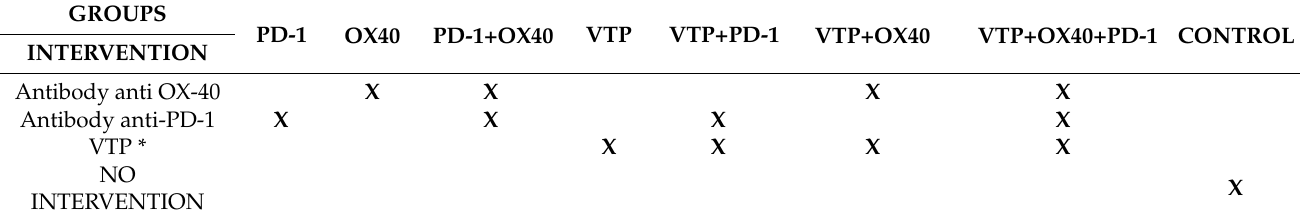
Table 1. Therapeutic schemes received by each